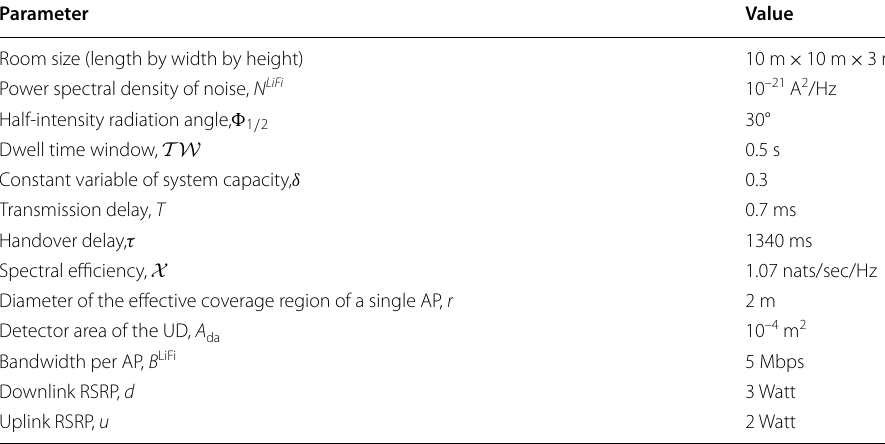
Table 1 Key simulation